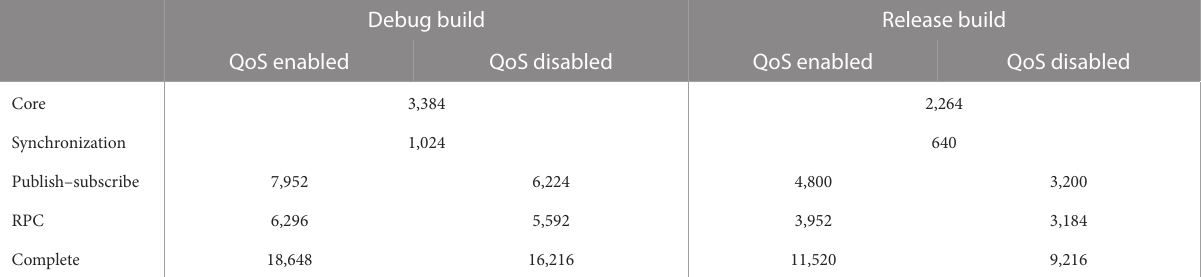
TABLE3 MemoryfootprintofµRTinacompiledimage.ResultshavebeenobtainedonaSTM32-F405RG(32-bitArmCortex-M4),forwhichthevalueswere thelargestamongallevaluatedMCUs. 10 CodehasbeencompiledusingGCC11.3.1(ArmGNUToolchain)withoptimizationssuchasgarbagecollection(GC) andlinktimeoptimization(LTO)disabled.FurthersettingsofµRThavebeenconfiguredtoreasonablevalues;fore.g.,identifiersizesfor topics and services